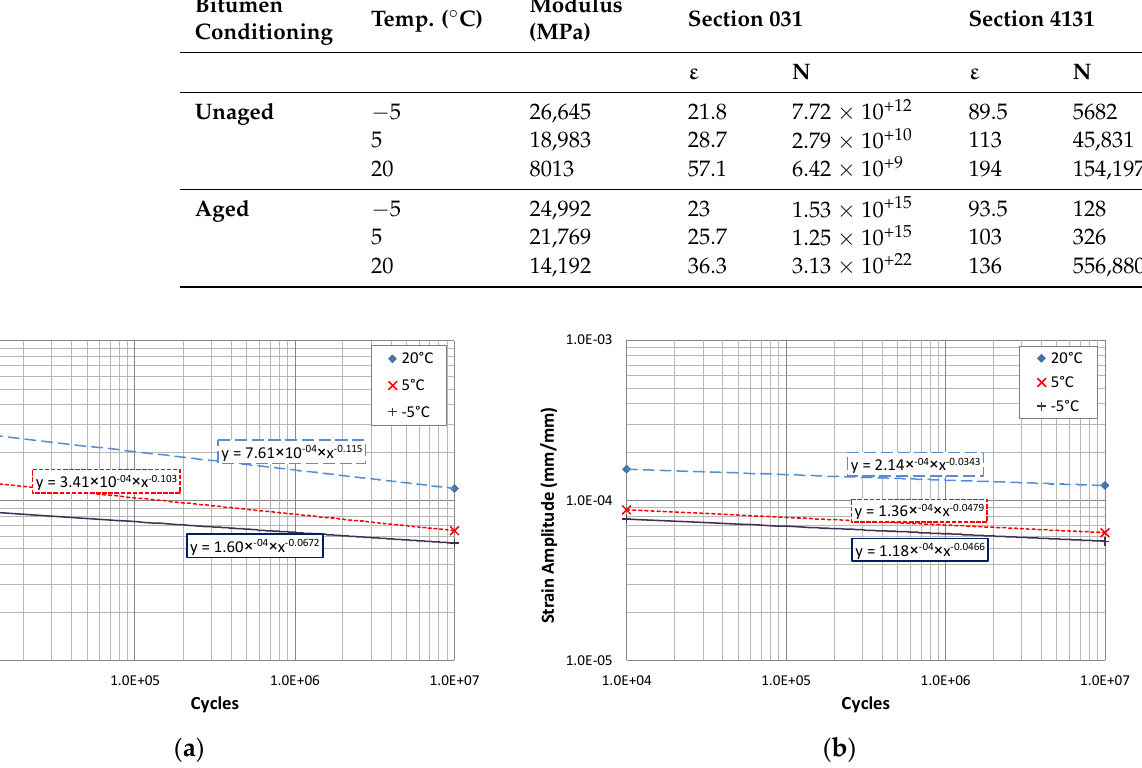
Figure 12. Fatigue law for ( a ) unaged mixture, ( b ) aged mixture.